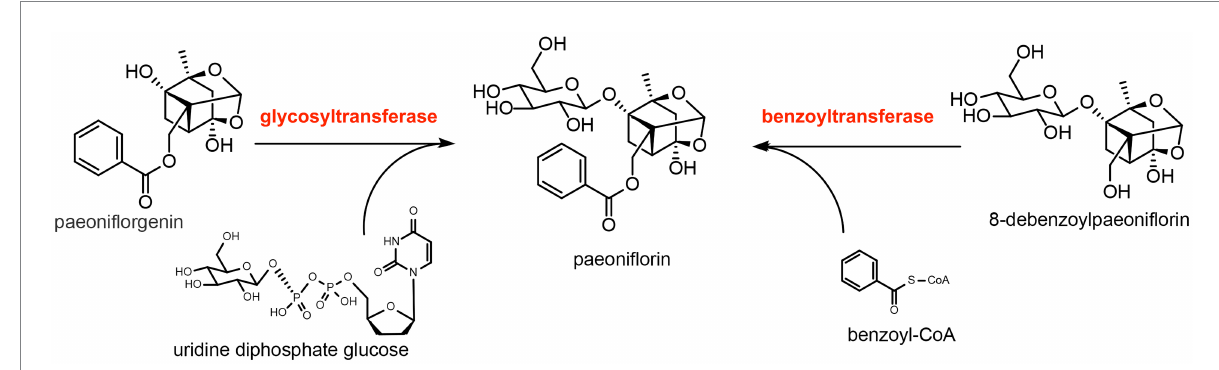
FIGURE 2 Predicted synthesis of paeoniflorin catalyzed by glycosyltransferase and benzoyltransferase. The substrate of glycosyltransferase is paeoniflorgenin and the glycosyl donor is uridine diphosphate glucose. The substrate of benzoyltransferase is 8-debenzoylpaeoniflorin and the benzoyl donor is benzoyl-CoA.